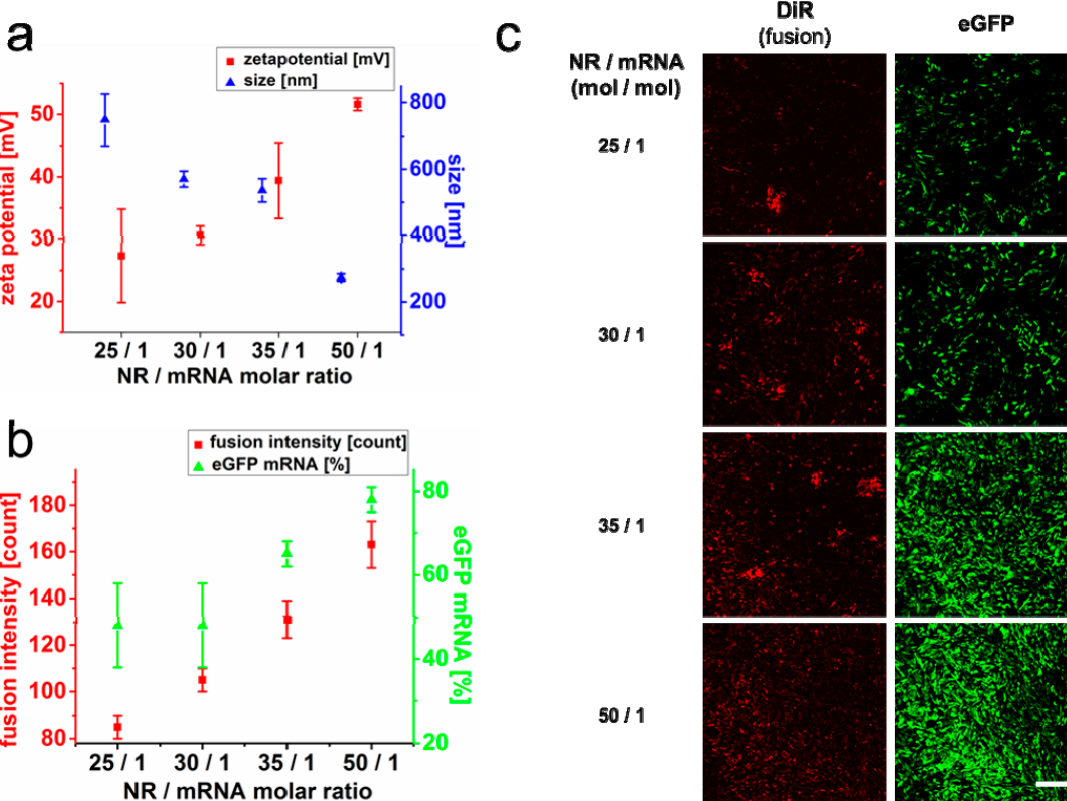
Figure 3. Effects of nucleic acid neutralization on liposomal complex characteristics and cellular transfer efficiency. Chinese hamster ovary cells (CHOs) were treated with FLs loaded with twofold eGFP–mRNA amounts previously neutralized with different amounts of protamine as NR to enhance the size effect of the protamine-neutralized mRNA complexes. Particle size and zeta potential were determined by dynamic and electrophoretic light scattering, respectively ( a ), and are well comparable to the corresponding ratios given in Figure 2. Fusion intensity as well as protein expressions (eGFP) were quantified by flow cytometry ( b ) and visualized by confocal microscopy recording the fluorescence emission of the membrane tracer DiR (red) and eGFP (green) ( c ). Values are given as mean with standard deviation of three independent measurements. Scale bar, 250 µ m. NR = neutralization